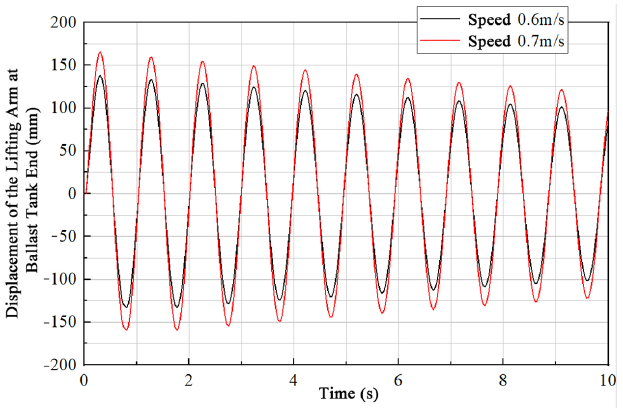
Figure 12. Displacement Response of the Lifting Arm at the Ballast Tank End with the Speed of 0.6 or 0.7 m/s.